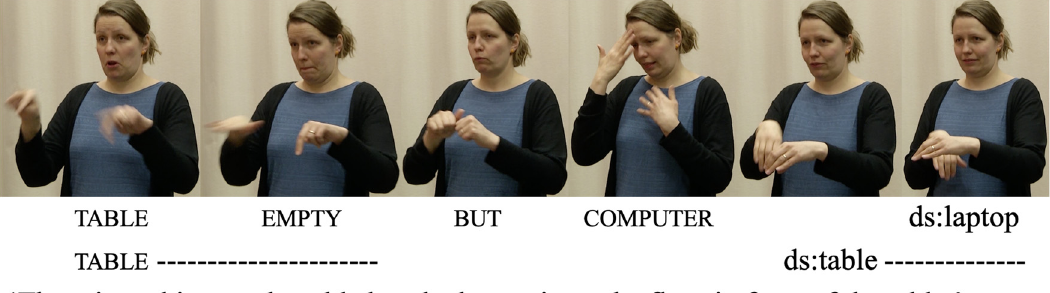
Figure 11: An example of the simultaneous production of depicted Ground and known